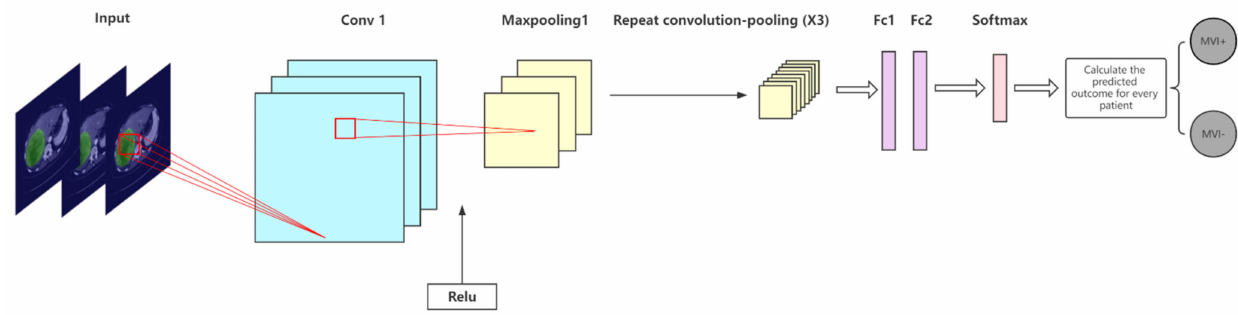
Figure 4. Convolutional neural network (CNN) designed to extract region-of-interest (ROI) features and make predictions in this